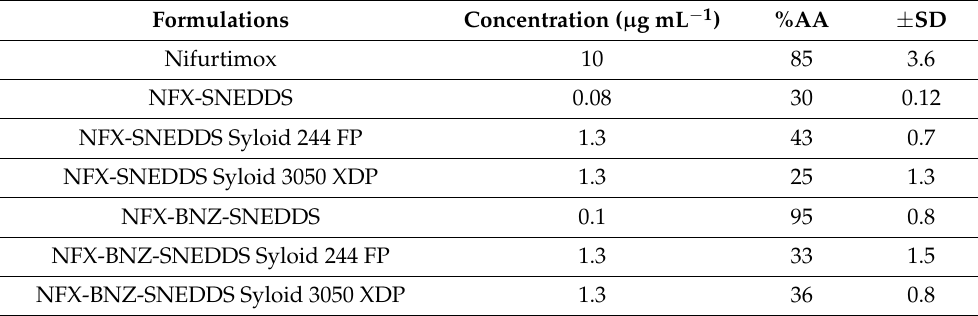
Table 7. Antiamastigote activity of NFX and BNZ formulations on T. cruzi infected NCTC929 fibroblasts. Formulations Concentration ( µ g mL − 1 )